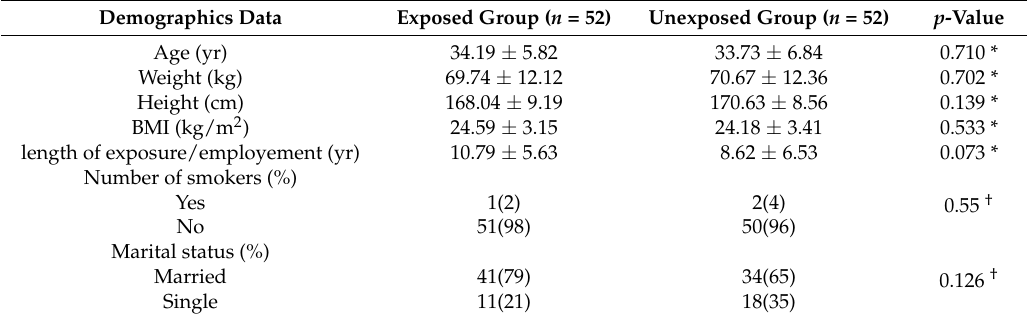
* Independent sample t test. † Chi-square test.